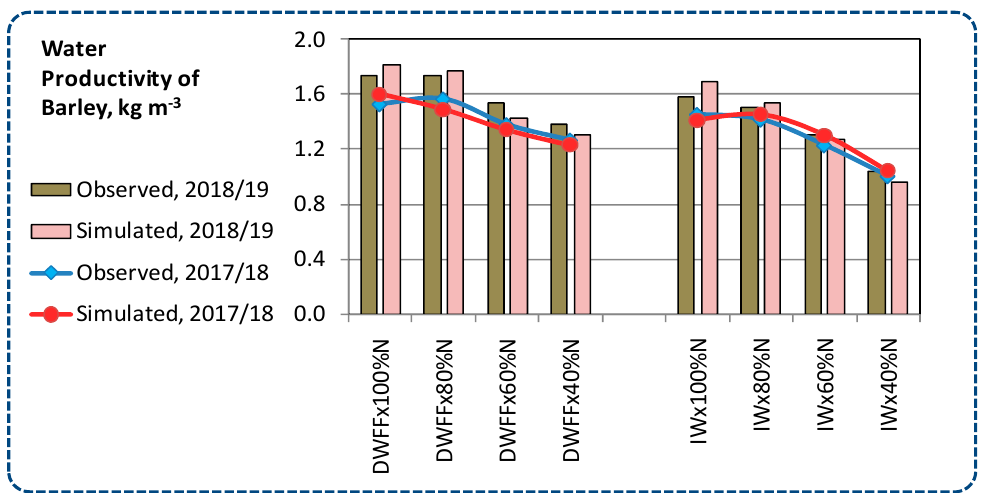
Figure 16. Effect of water quality types and nitrogen fertigation rate on the observbed and simulated water productivity of barley for the 2017/2018 and 2018/2019 seasons for all treatments: drainage water from fish farms(DWFF); fresh irrigation water (IW) and nitrogen (N).